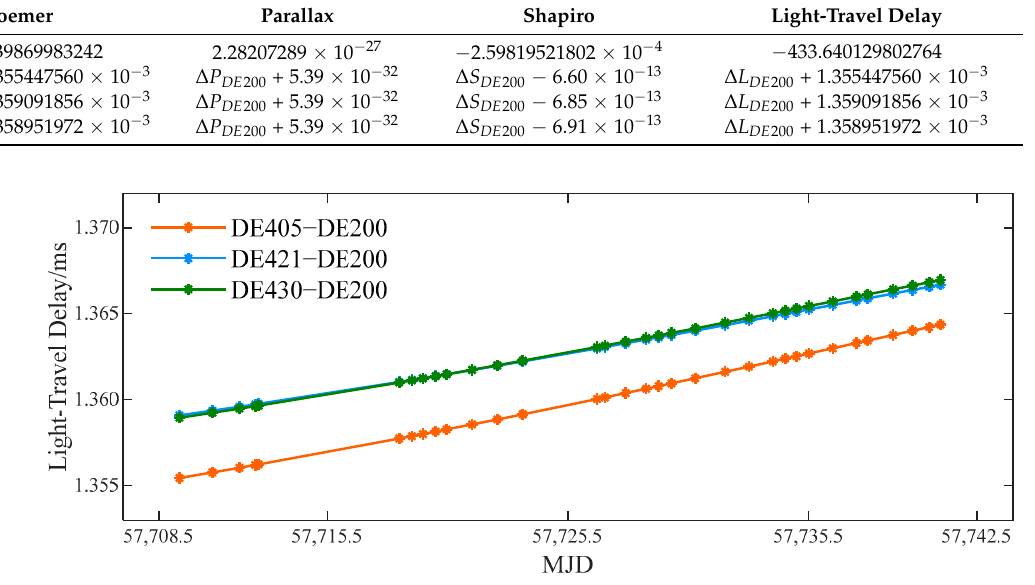
Figure 2. Comparison of time delay during data observation. The meaning of each curve is the same as that in Figure 1, and “DE405-DE200” represents the difference between the light-travel delay calculated by DE405 and DE200, and the rest are analogous.